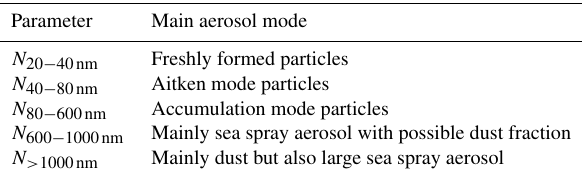
Table 2. The input parameter x i for K -means and the correspond- ing main aerosol mode and